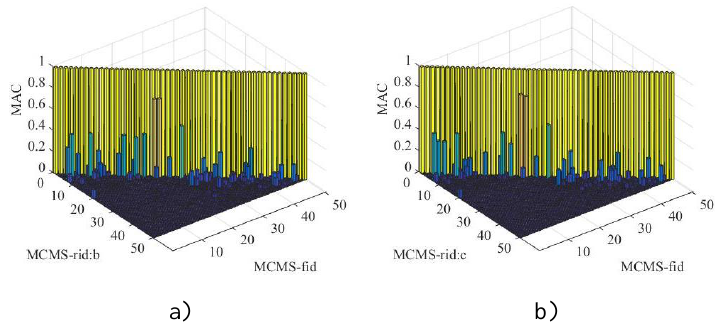
Figure 16. Modal assurance criterion between the modes by the MCMS-fid method and MCMS-rid